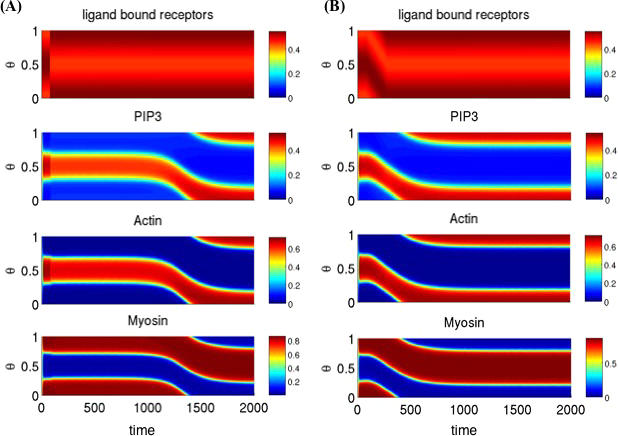
Response to Fast and Slow Rotating GradientsTime to complete 180° rotation is 0.01 (A) and 100 (B) time units. Abscissa is time, ordinate is location on cell periphery, and color denotes concentration. Chemoattractant concentration on the surface of the cell was specified by the function L(θ) = 1 − 0.25 cos(2πθ).